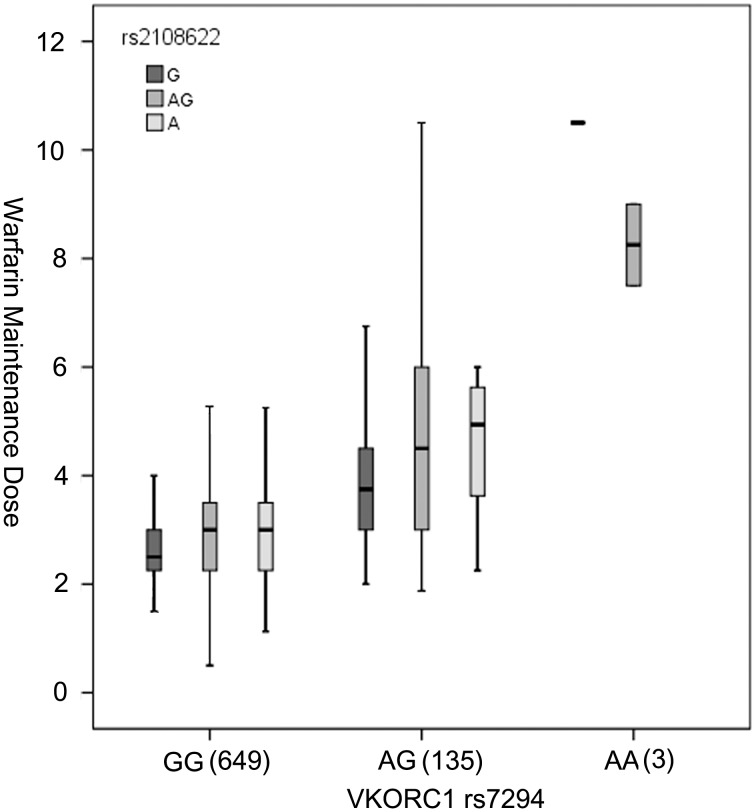
The effect of CYP4F2 rs2108622 on warfarin maintenance dose grouped by VKORC1 rs7294 genotypes (mg/day).Each box indicates the 25th to 75th percentile values (interquartile range); the black lines represent the median daily warfarin maintenance dose value, the maximum length of the whisker is 1.5 times the interquartile range. In detail below are the specific statistical significances for each group. VKORC1 rs7294 GG: P
ANOVA = 0.030; P
Spearman = 0.005. VKORC1 rs7294 AG: P
ANOVA = 0.031, P
Spearman = 0.027.